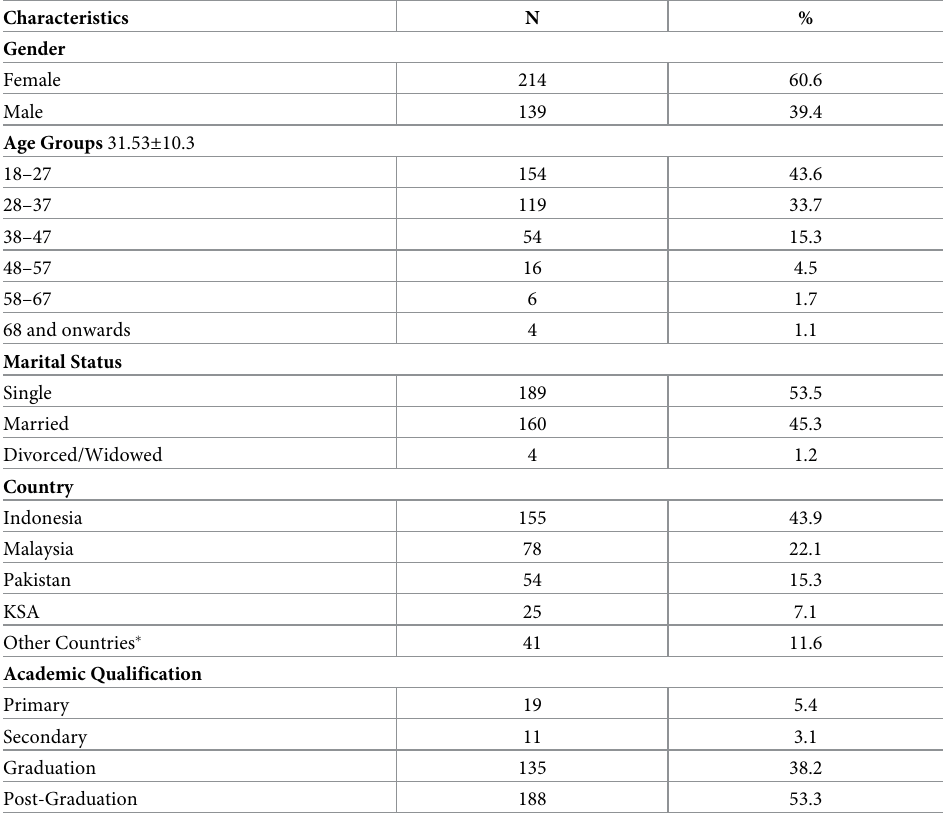
Table 1. Demographic features of